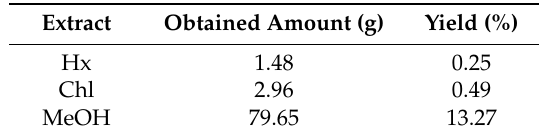
Table 3. Yields of extracts obtained from Egregia menziesii